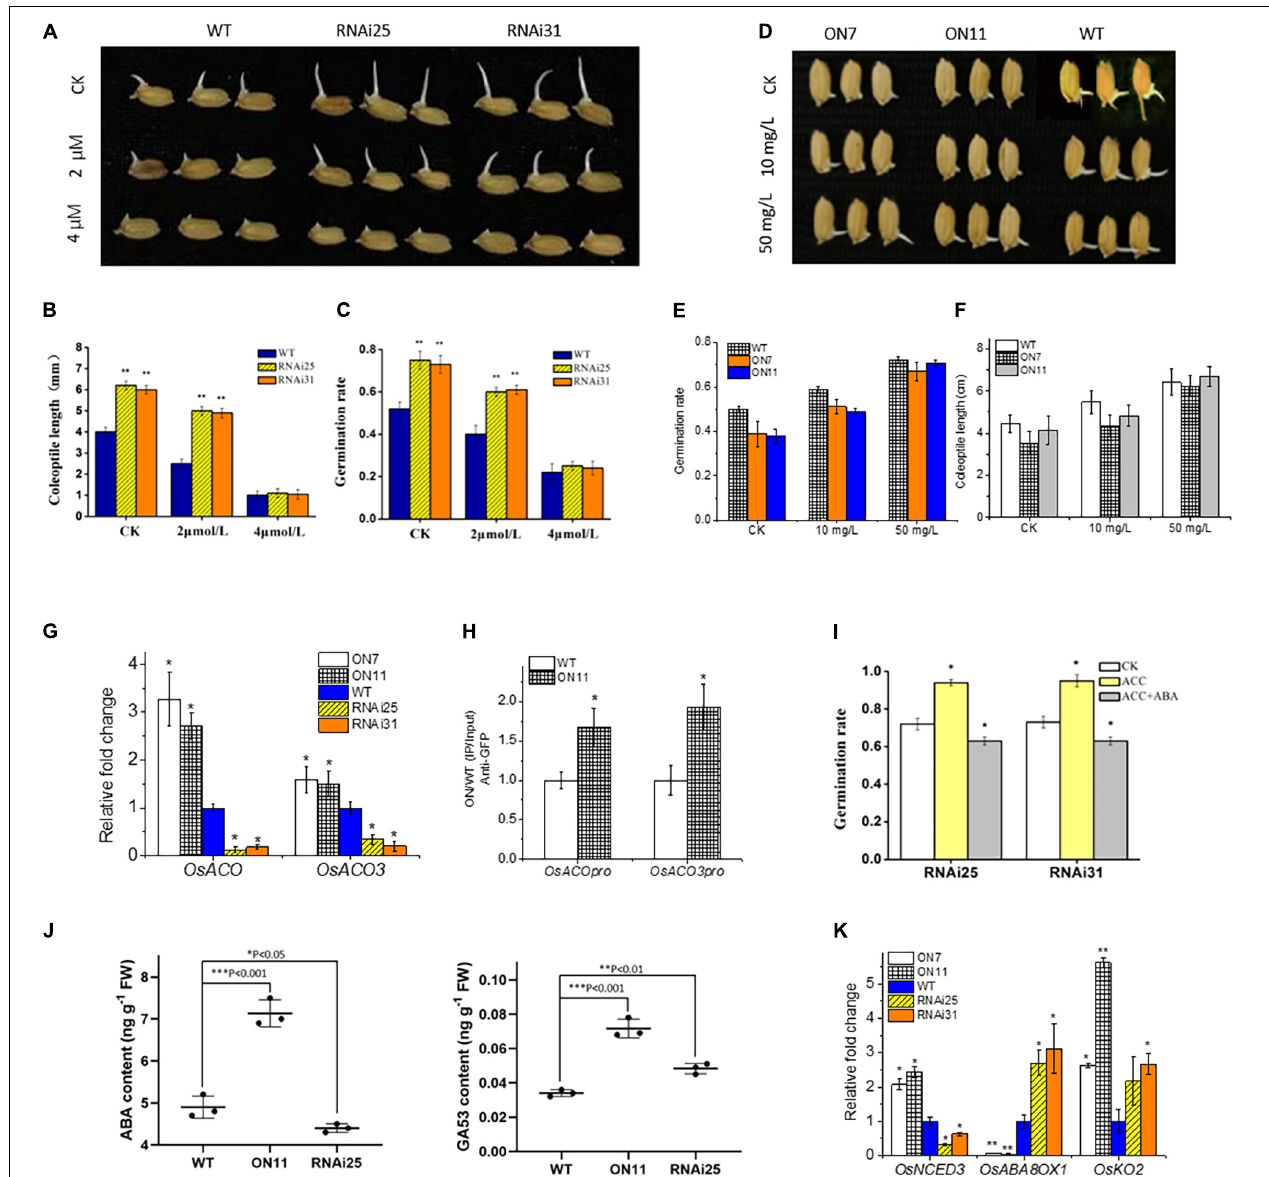
FIGURE 4 | Effects of OsNAC2 on the ethylene and the abscisic acid (ABA) pathways at the stage of the germination of seeds. (A) Germination phenotype of the wild-type (WT) and OsNAC2-knockdown transgenic seeds treated with 2 or 4 µ mol/L of ABA for 24 h. (B) Coleoptile length of the WT and OsNAC2-knockdown transgenic seeds treated with 2 or 4 µ mol/L of ABA for 24 h. (C) The germination rate of the WT and OsNAC2-knockdown transgenic seeds treated with 2 or 4 µ mol/L of ABA for 24 h. (D) Germination phenotype of the WT and OsNAC2 -overexpressing seeds treated with 10 or 50 mg/L of ABA biosynthesis inhibitor fluridone for 24 h. (E) The germination rate of the WT and OsNAC2 -overexpressing seeds treated with 10 or 50 mg/L of ABA biosynthesis inhibitor fluridone for 24 h. (F) Coleoptile length of WT and OsNAC2 -overexpressing seeds treated with 10 or 50 mg/L of ABA biosynthesis inhibitor fluridone for 24 h. (G) Expressions of OsACO and OsACO3 in the WT and OsNAC2 -transgenic seeds during germination. (H) Chromatin immunoprecipitation–quantitative polymerase chain reaction (ChIP–qPCR) assay of OsNAC2 on the promoters of OsACO and OsACO3 . (I) The germination rate of the WT and OsNAC2-knockdown transgenic seeds treated with 30 µ mol/L of 1-aminocyclopropane-1-carboxylic acid (ACC) or 2 µ mol/L of ABA and 30 µ mol/L of ACC for 24 h. (J) ABA and GA production in OsNAC2-transgenic seeds. The rice seeds (RNAi25, ON11, and WT) were immersed in pure water at 30 and 37 ◦ C, respectively, for 24 h. (K) Expressions of ABA and GA metabolism–related genes in the WT and OsNAC2 -transgenic seeds. Error bars represent the standard error of three biological replicates. * p < 0.05, ** p < 0.01, and * p <